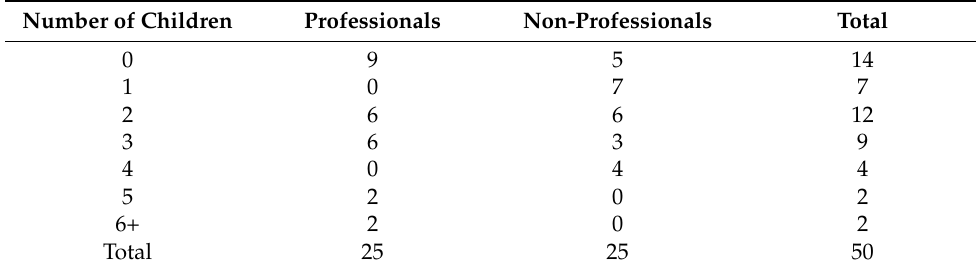
Table 2. Number of children according to educational